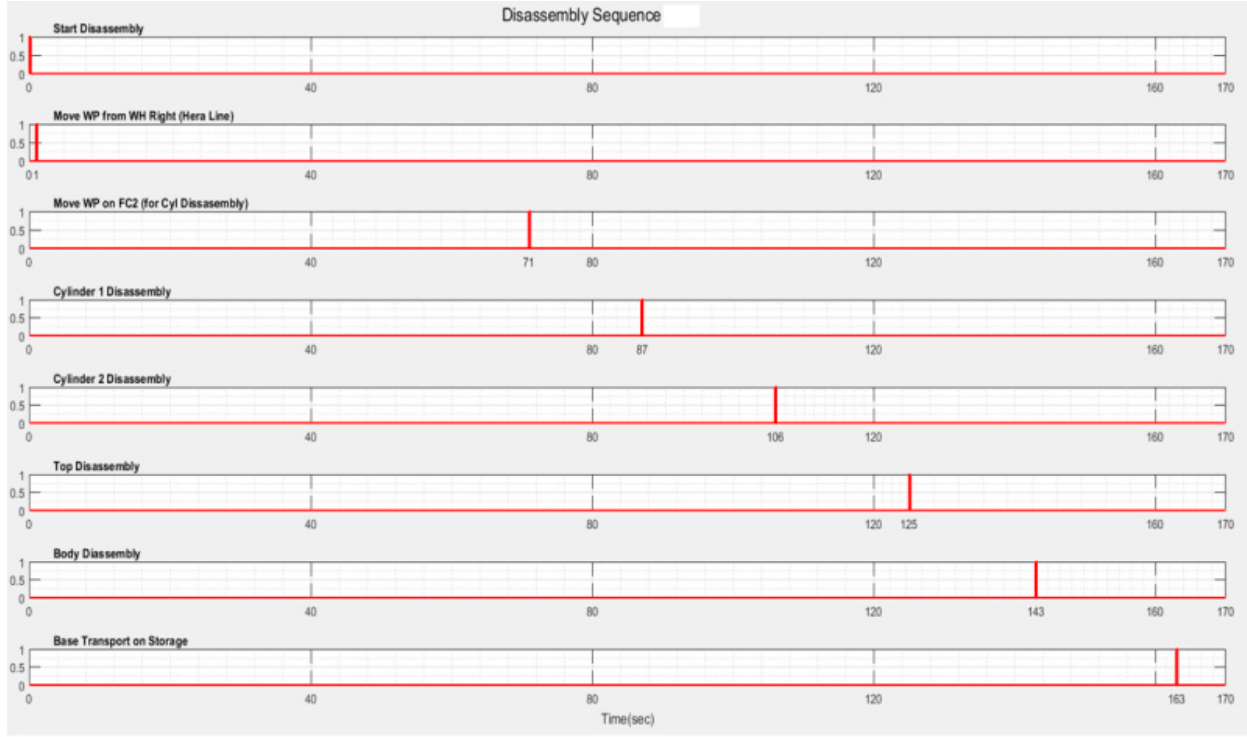
Figure 21. Real-time monitoring signals corresponding to disassembly operations of WP2.